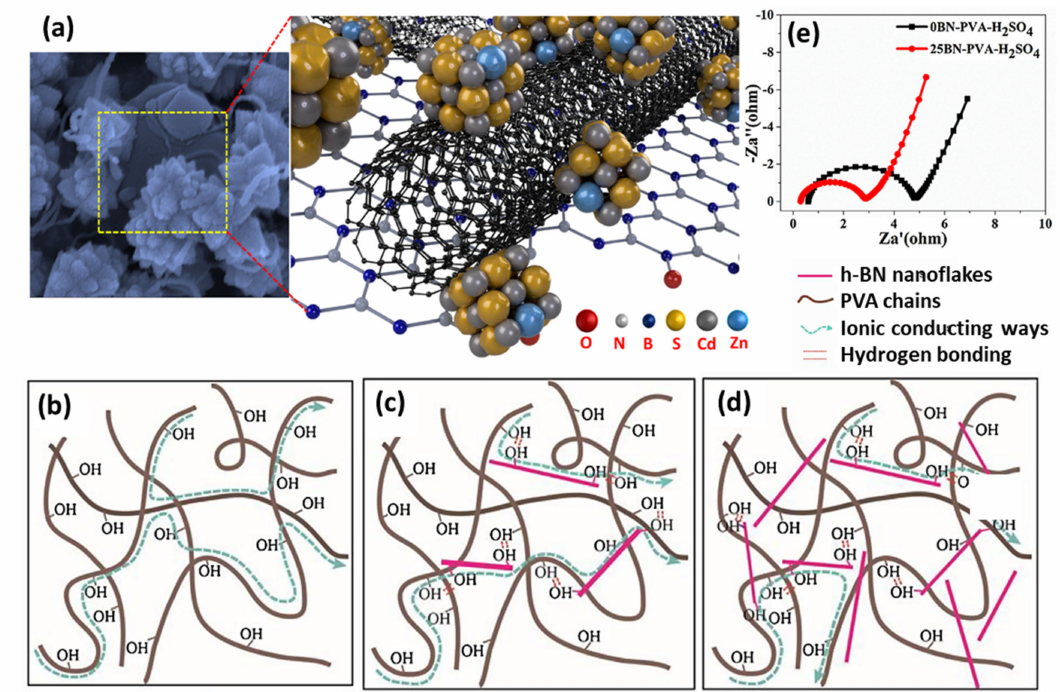
Figure 6. ( a ) Schematic representation of the cathode matrix with functionalized boron nitride sheets, carbon nanotubes, and Zn-doped CdS nanoparticles along with a FESEM image [105]. (Reprinted with permission from Elsevier B. V, Copyright © 2021). Illustration of ionic conduction process for ( b ) ions conduction along the twisted PVA chains, ( c ) proper amount of 2D h-BN leading to direct conduction of ions and ( d ) an excessive amount of 2D h-BN hindering the conduction of ions ( e ) EIS of supercapacitors with 0 and 25% h-BN-PVA-H 2 SO 4 GPE [117] (Reprinted with permission from Elsevier B. V, Copyright ©